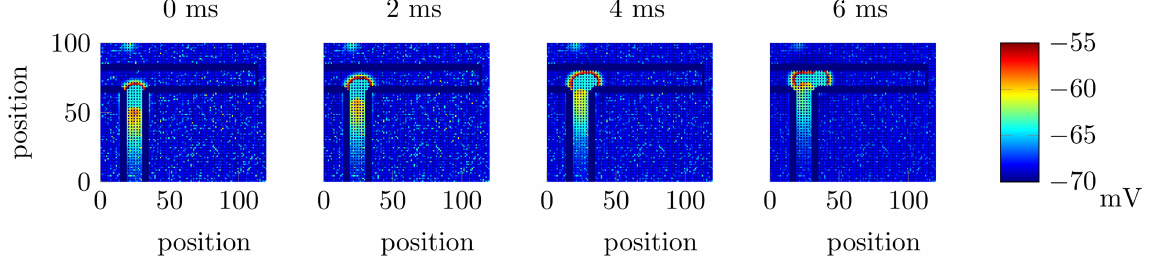
Fig 2. Forward-sweeping neural sequences at the decision point. Each frame is 2 ms after the previous one during a test trial and shows a snapshotof the membranepotentials of the excitatory neuronsfrom a regionof the network near the intersection of the T-maze. These snapshotsare taken from the network with synapticscaling, althoughwithout synaptic scaling, similar behaviour is seen on successful trials, but the proportionof successful trials is reduced. Neuronsare locatedat integer locationsalong both axes.